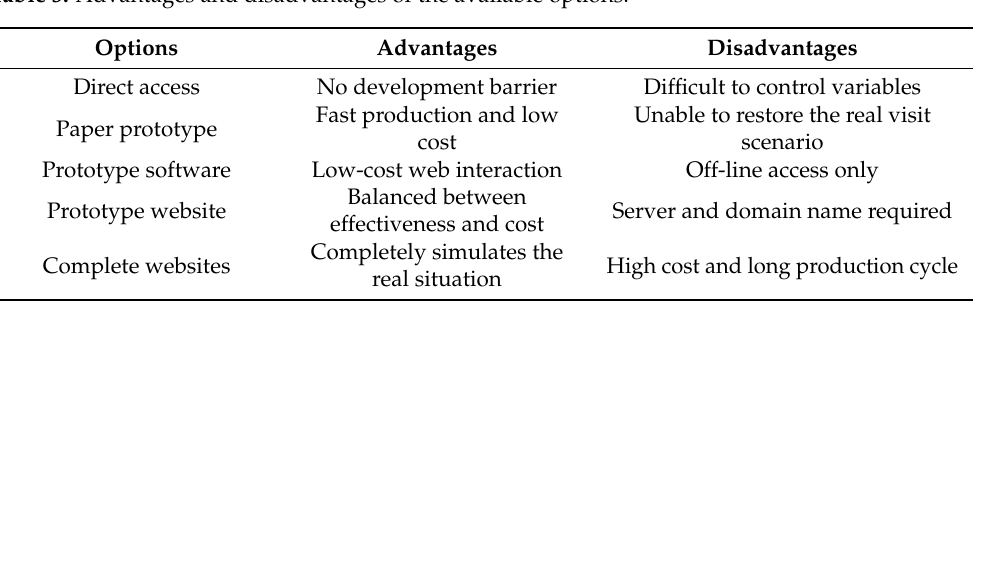
Table 3. Advantages and disadvantages of the available